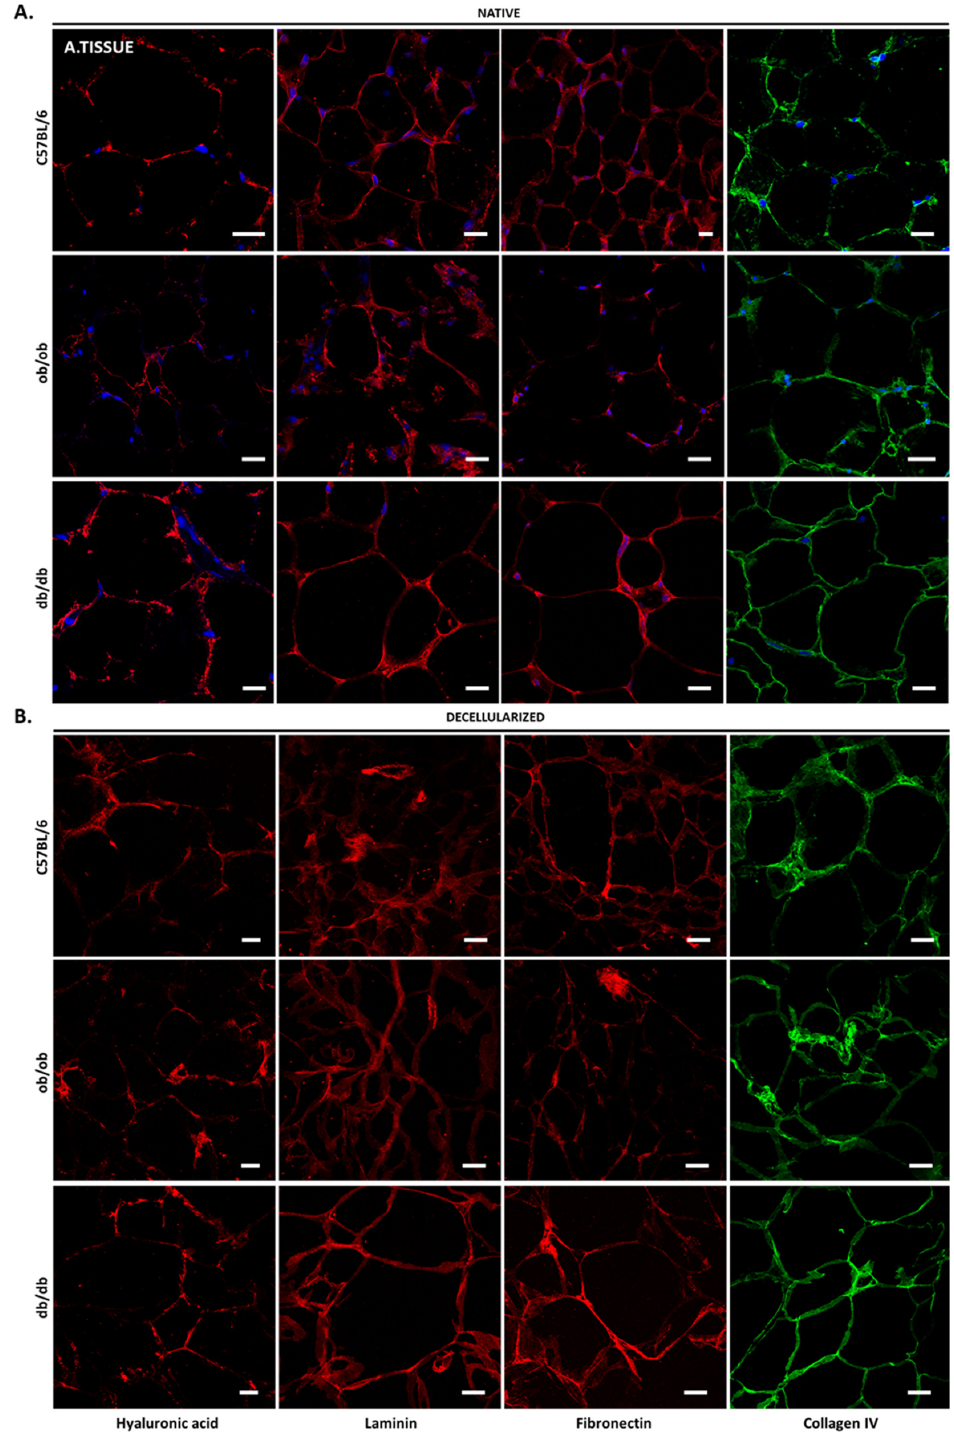
Figure 6. Acellular intraperitoneal adipose tissue retains its ECM components. Confocal microscopy images of native ( A ) and decellularized ( B ) adipose tissue sections from C57BL/6J, ob/ob, and db/db mice. Shown are immunofluorescence results for hyaluronic acid (first column), laminin (second column), fibronectin (third column), and collagen IV (forth column). DAPI staining indicates cell nuclei. Scale bar: 100 µm.